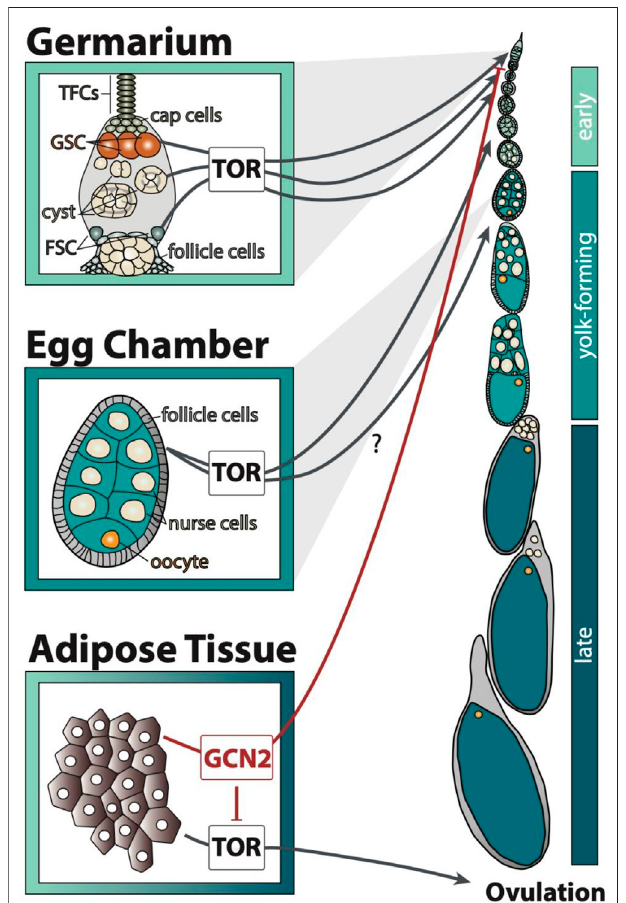
FIGURE 1 | GCN2 and TOR signalling in the adipose tissue and ovary transmitaminoacidavailability byaffecting distinctprocesses ofeggchamber development. Early stages include stages 1 – 7, yolk-forming includes stages 8 – 11,andlateincludesstages12 – 14ofeggchamberdevelopment.The question mark indicates that it is unclear through which cell type TOR regulates the yolk-forming stages. TFCs: terminal fi lament cells, GSC: germline stem cells, FSC: follicle stem